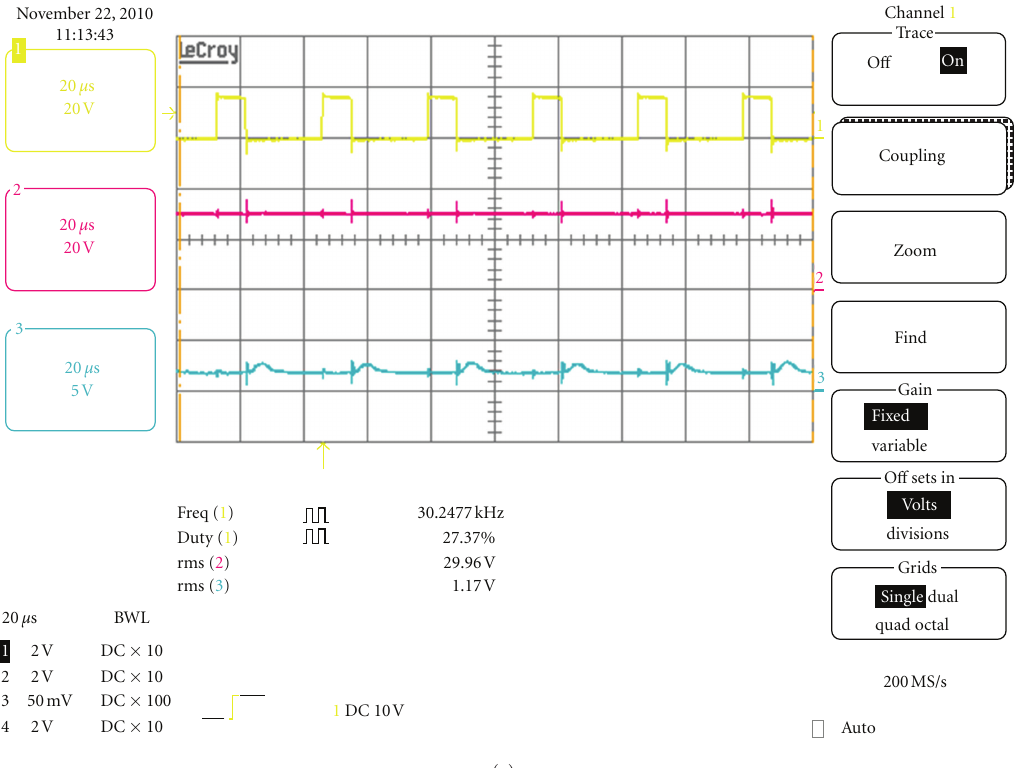
Figure 10: (a) The wave forms of 21 V and 1.47 A at Point D. (b) The wave forms of 25V and 1.43 A at Point E. (c) The wave forms of 30V and 1.17 A at Point